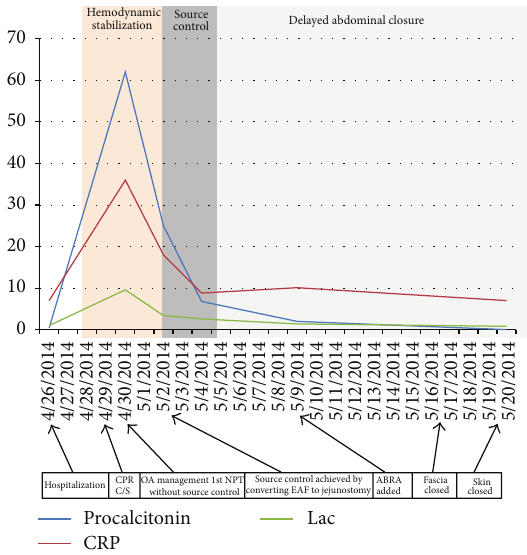
Figure 1: All the important interventions are given on the scale and change intheCRP,lactate, and procalcitonin level according to these interventions from hospitalization to closure of OA.